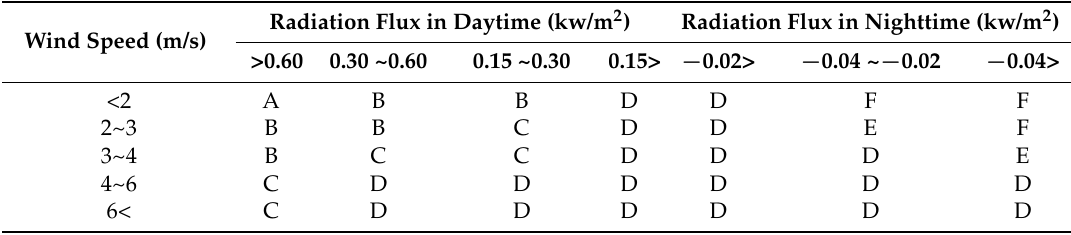
Table 2. Categorization of atmospheric stability